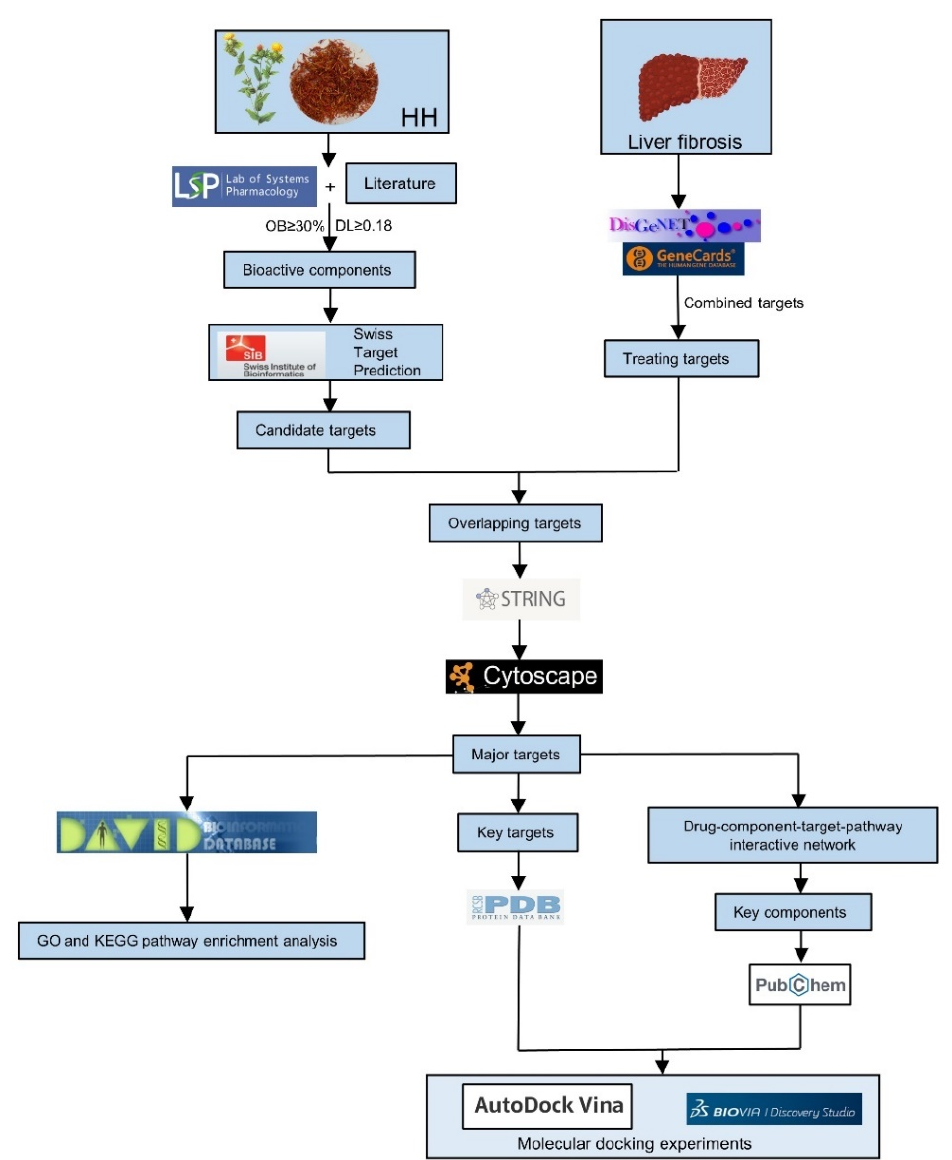
Figure 1. Research strategies for the current study.